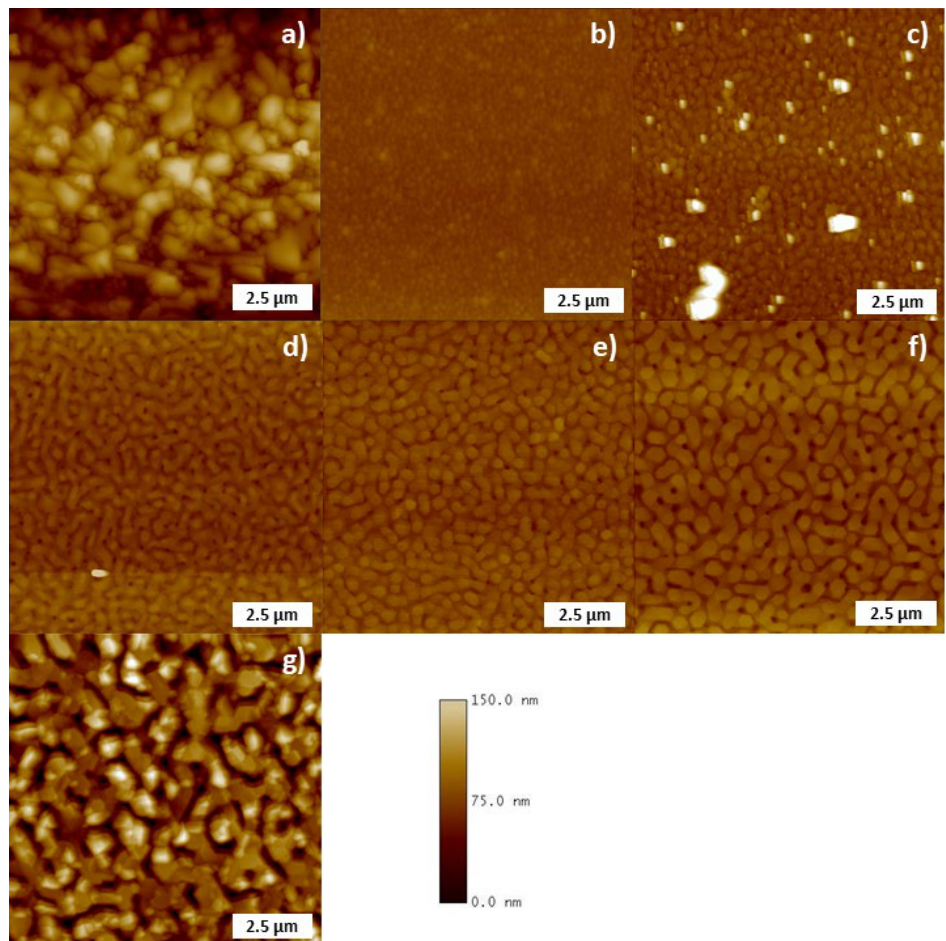
Figure 2. AFM images of Gd films grown on AlN (0001) at ( a ) 80 °C, ( b ) 210 °C, ( c ) 240 °C, ( d ) 255 °C, ( e ) 270 °C, ( f ) 330 °C and ( g ) 400 °C.